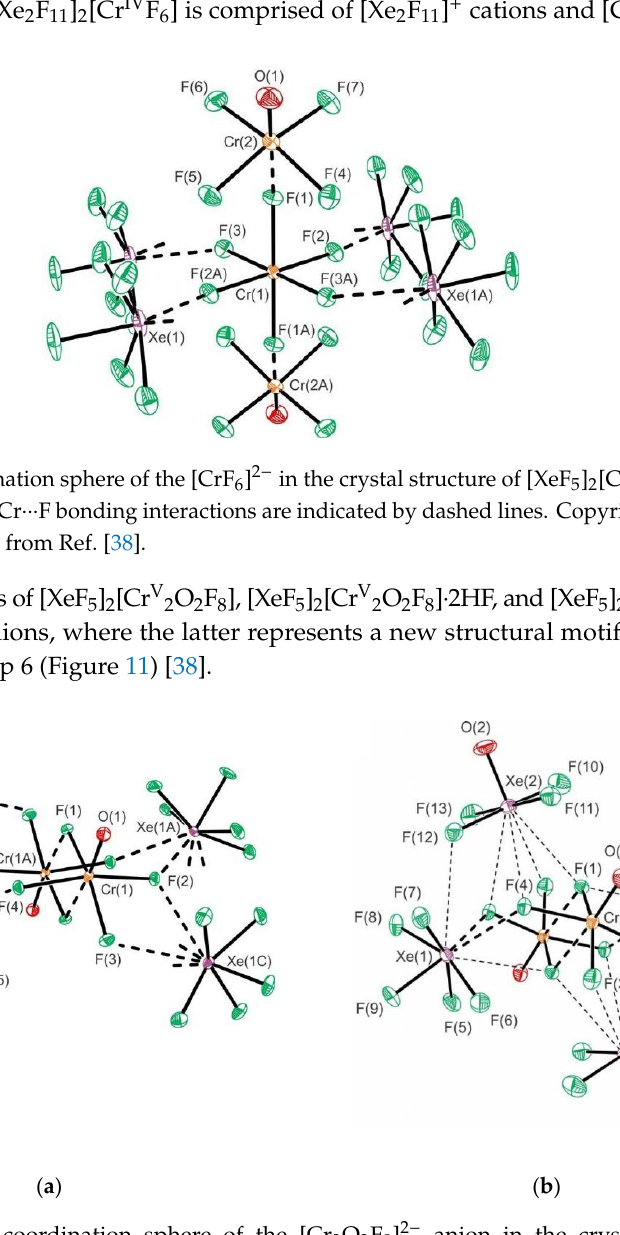
Figure 11. ( a ) The coordination sphere of the [Cr 2 O 2 F 8 ] 2 − anion in the crystal structure of [XeF 5 ] 2 [Cr V 2 O 2 F 8 ]. Secondary Xe ··· F bonding interactions and Cr ··· F b bridge bonds are indicated by dashed lines; ( b ) The coordination environment around the [Cr V 2 O 2 F 8 ] 2 − anion in the crystal structure of [XeF 5 ] 2 [Cr V 2 O 2 F 8 ] · 2XeOF 4 . Secondary Xe ··· F bonding interactions and Cr ··· F b bridge bonds are indicated by dashed lines. Copyright (2019) Wiley. Used with permission from Ref.